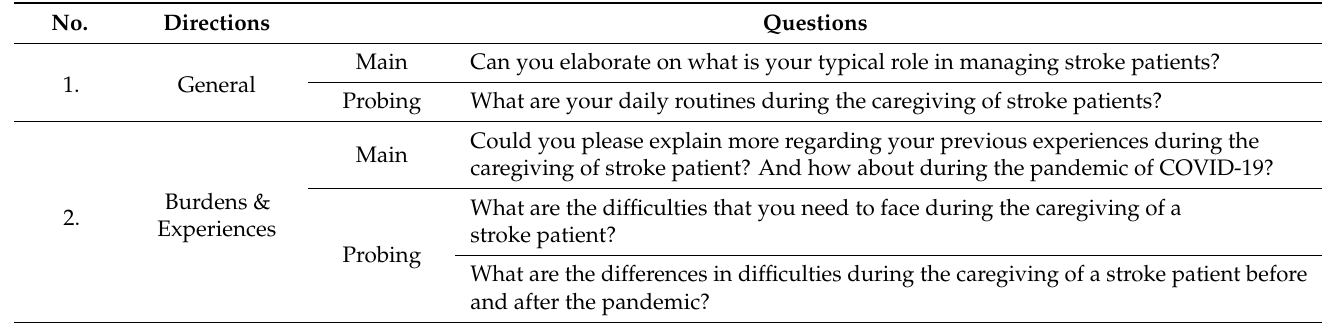
Table A1. Examples of Main and Probing